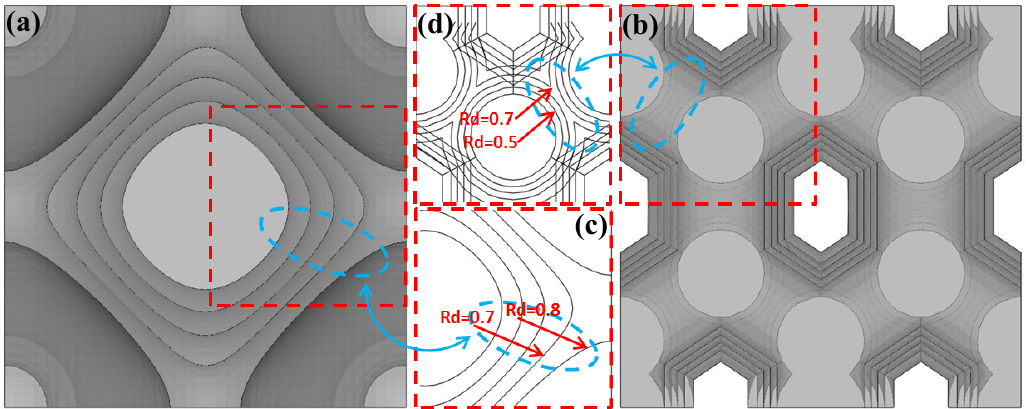
Figure 10. Superimposed effect diagrams of: ( a ) the top view in rendering mode of the primitive unit cell under the five relative densities; ( b ) the top view in the rendering mode of the honeycomb unit cell under the five relative densities; ( c ) the partial top view of the primitive unit cell in wireframe mode (red arrows indicate the unit cell top profiles with relative densities of 70% (Rd = 0.7) and 80% (Rd = 0.8)); and ( d ) the partial top view of the honeycomb unit cell in wireframe mode (red arrows mark the top profiles of the vertical pillar inside the honeycomb unit cell with relative densities of 50% (Rd = 0.5) and 70% (Rd =